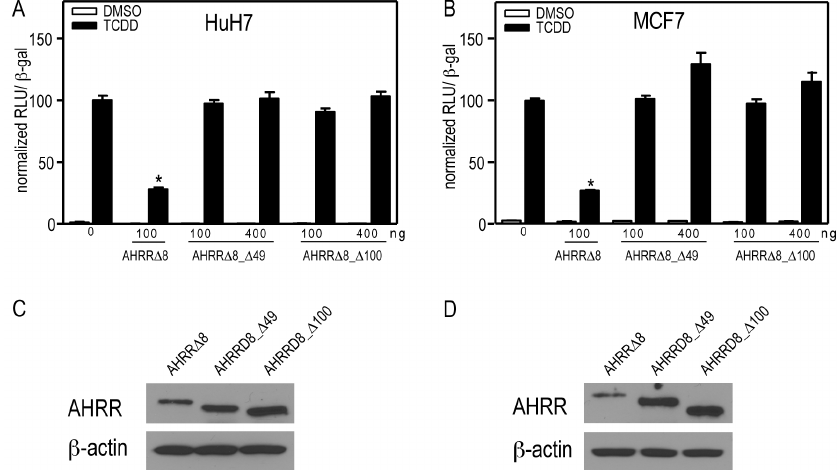
Figure 8. AHRR Δ 8_ Δ 1-49 and AHRR Δ 8_ Δ 1-100 do not repress CYP1A1-regulated reporter gene activity in HuH7 or MCF7 cells. ( A ) HuH7 or ( B ) MCF7 cells were transfected with pCYP1A1-luc and pcDNA-AHRR Δ 8 or increasing concentrations of pcDNA-AHRR Δ 8_ Δ 1-49 and pcDNA-AHRR Δ 8_ Δ 1-100. Cells were then treated with TCDD for 24 h and reporter gene activity determined. The data are presented as means ± SEM of three independent replicates. Reporter gene activity significantly less ( p < 0.05) than cells transfected AHRR Δ 8 is denoted by an asterisk. Protein expression levels of AHRR Δ 8 and AHRR Δ 8 variants in transfected ( C ) HuH7 or ( D ) MCF7 cells was determined by Western blotting. Data shown were representative of three independent